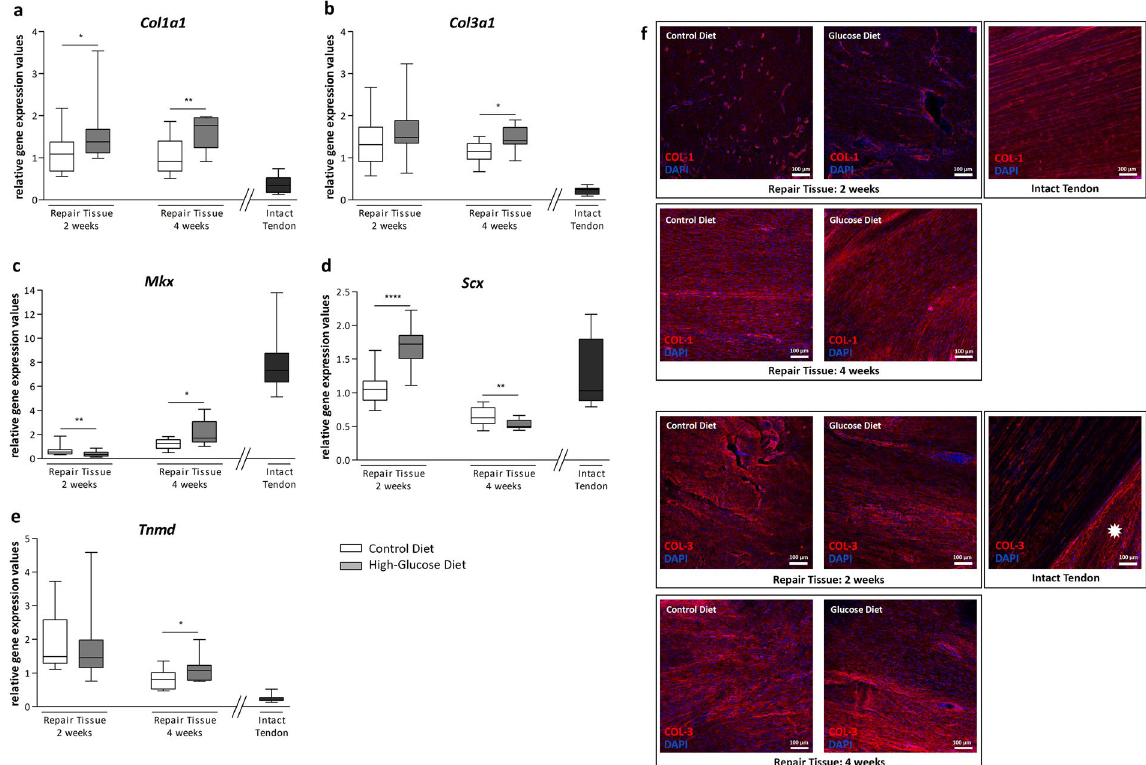
Figure 5. Analysis of COL1 and COL3 and tenogenic marker gene expression. Quantitative PCR analysis of Col1a1 ( a ) and Col3a1 ( b ) and the tenogenic lineage associated genes Mkx ( c ), Scx ( d ), and Tnmd ( e ) in the repair tissues of the control diet group and the high-glucose diet group after 2 and 4 weeks. COL1 staining was mostly confined to capillaries within the repair tissue after 2 weeks whereas a deposition of collagen type 1 in the extracellular matrix of the repair tissue was observed after 4 weeks. Strong COL1 staining in intact tendon tissue is shown as a reference ( f ). Substantial collagen type 3 deposition in the extracellular matrix was seen after 2 and 4 weeks. Note the strong COL3 staining in the epitenon ( asterisk ) of intact tendon tissue ( g ). Compared to intact tendons, Tnmd expression was increased 2 and 4 weeks after surgery. Mkx expression was lower in the repair tissues, showing no substantial change over time. Scx expression 2 weeks post-tenotomy was comparable to intact tendons. 4 weeks post-surgery Scx transcript levels were lower, the decrease being strongest for the high-glucose group. Values for intact tendons are provided as a reference (n =